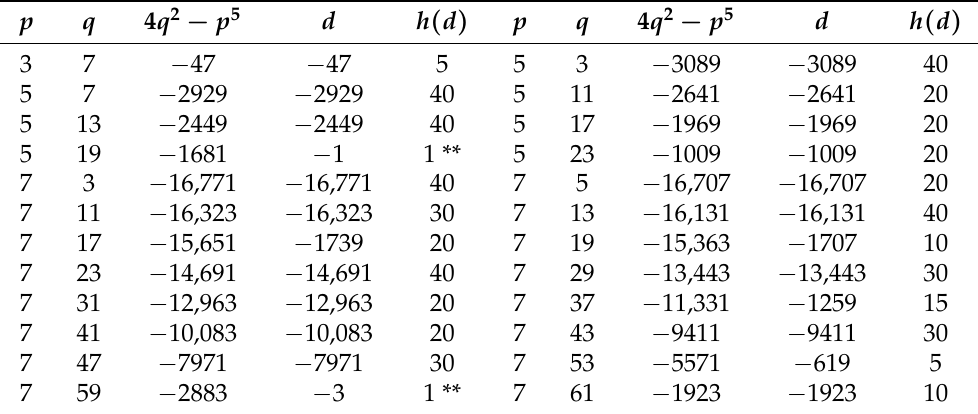
Table 3. Numerical examples for n = 5.